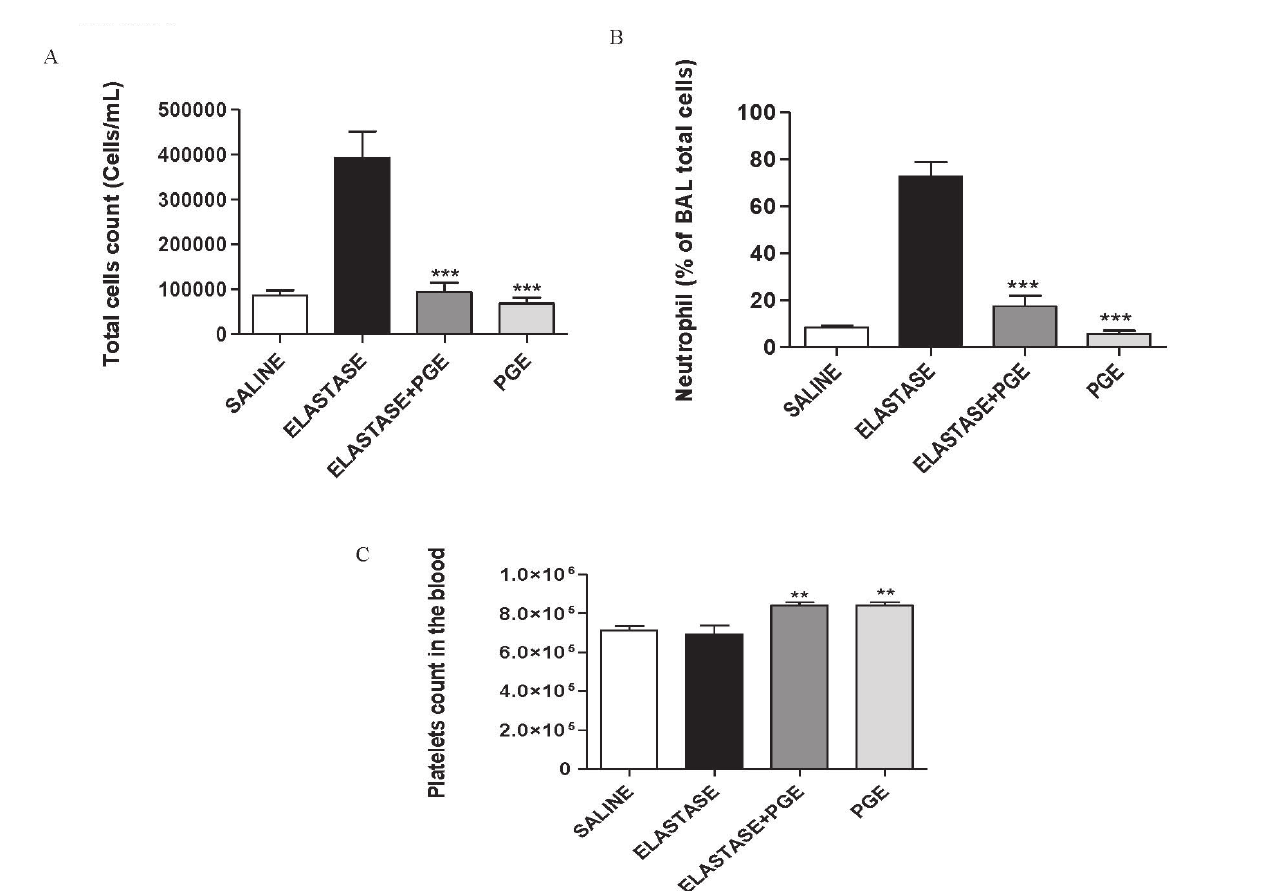
FIGURE 3 – Effect of PGE on cell content. Animals were treated with PGE (200 mg/kg), Elastase (25U/kg) or PGE (200 mg/kg) + Elastase (25 U/kg), and cells were counted 7 days after the treatment. (A), Total cell counts in BAL; (B) Neutrophil counts in BAL; (C) Platelets count (n=5, mean ± SEM